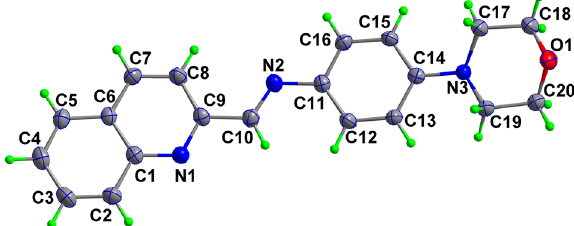
Table  : Data collection and handling.